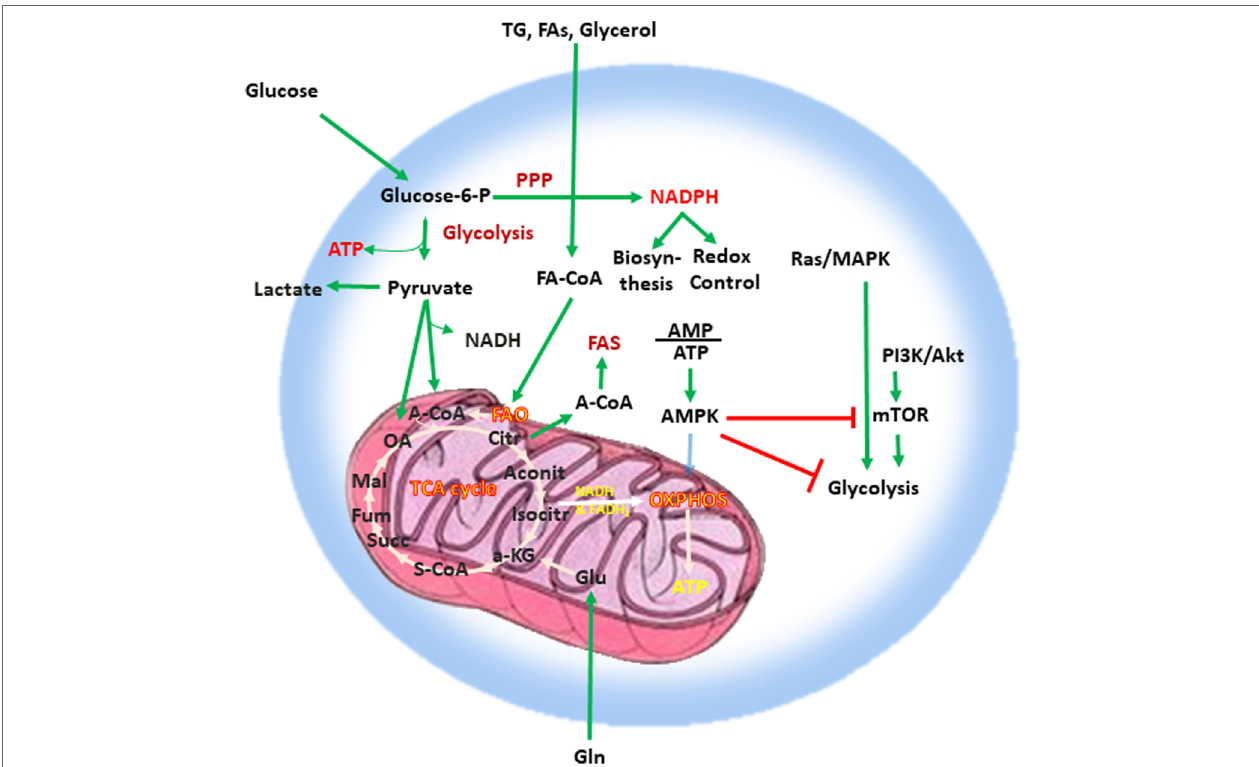
FiGURe 1 | Metabolism is a key feature of every quiescent cell. Quiescent cells generate ATP by glycolysis and OXPHOS. Metabolism can be weighted toward anabolic reactions or toward catabolic reactions. Glucose is one of the main nutrients from which all types of cells generate energy. Glycolysis converts glucose into pyruvate via sequential enzymatic reactions, which lead to the generation of intermediate metabolites that can enter other pathways, such as the PPP. These coordinated metabolic processes are critical for successful biosynthesis and cell growth. Pyruvate generated from glycolysis can enter the mictochondria and can be converted into acetyl-CoA entering the TCA cycle or can be converted into lactate in the cytoplasm and excreted from the cell. Glycolysis also helps in the maintenance of the NAD + –NADH redox balance. Cells also use glutamine (Gln), which is metabolized by glutaminolysis, and lipids (TG, FA, and glycerol), which are metabolized by fatty acid oxidation. The intermediates produced by these catabolic processes enter the TCA cycle. The TCA cycle provides key substrates for biosynthesis, such as citrate, which can be exported to the cytosol and form the basis for FAS, whereas OXPHOS generates a high number of ATP thereby providing the high levels of energy required for cell growth. Abbreviations: α -KG, alpha-ketoglutarate; A-CoA, acetyl coenzyme A; Aconit, aconitase; Akt, protein kinase B; AMP, adenosine monophosphate; ATP, adenosine triphosphate; AMPK, AMP-activated protein kinase; Citr, citrate; FA, fatty acid; FA-CoA, fatty acyl coenzyme A; FAS, fatty acid synthesis; Fum, fumarate; Gln, glutamine; Glu, glutamate; Isocitr, isocitrate; Mal, malate; MAPK, mitogen-activated protein kinase; mTOR, mechanistic/mammalian target of rapamycin; NADH, nicotinamide adenine dinucleotide reduced; OA, oxaloacetate; OXPHOS, oxidative